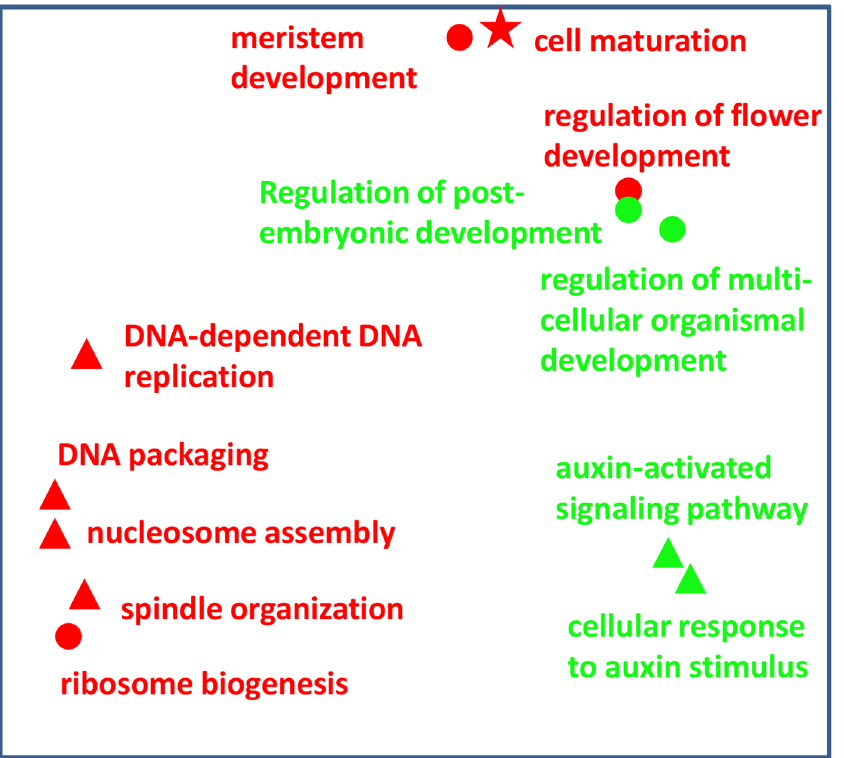
Fig 2. Connections with different biological process terms for three macroscopic traits (red) and two expression traits (green). Macroscopic traits includedare ‘root volume’(red triangles), ‘days to heading’(red circles) and ‘days to maturity’ (red star). Expression traits are LOC_Os01g10504(green circles) and LOC_Os04g30210(green triangles). At each symbol, the biological process (BP) term connectedto that trait is given. REVIGO [44] was appliedto obtain a plot in which the distancebetweensymbols indicates dissimilarity betweenBP terms. In this plot, the x- and y-axis do not have a direct meaning, but for each point, the x- and y-coordinatesare chosen so that terms with a high semantic similarity are close to each other in the plot.